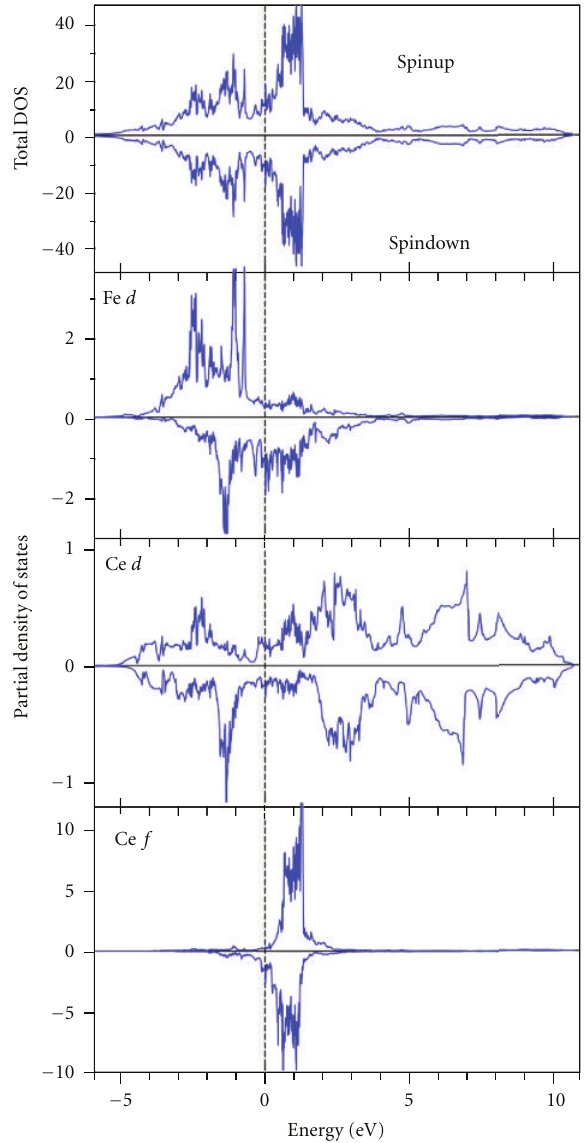
Figure 44: The total (in states/(cell eV)) and partial (in states/(atom eV)) densities of states of CeFe 2 [288]. The Fermi energy is at zero.